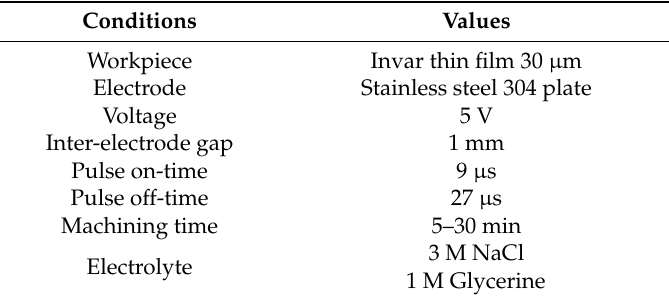
Figure 10. Schematic diagram of the electrochemical machining system. Table 1. ECM conditions for photoresist coating Invar thin film.